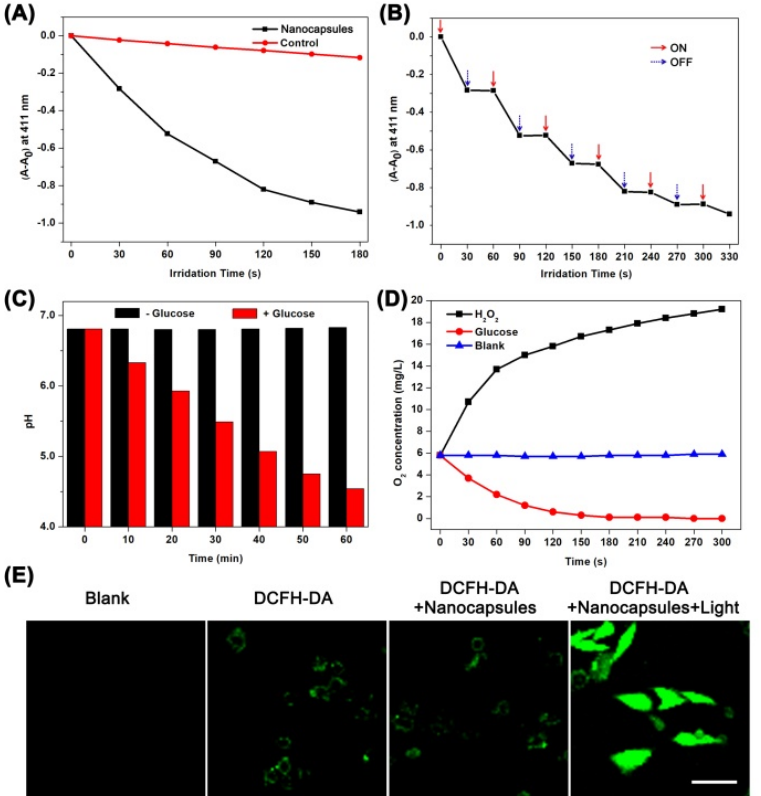
Figure 3. ( A ) The DPBF UV changes in the absence and presence of nanocapsules under infrared irradiation. ( B ) The DPBF UV changes in response of OFF-ON irradiation. ( C ) The pH value changes of GOx/CAT-NCs solution in the absence and presence of glucose. ( D ) The O 2 concentration changes of GOx/CAT-NCs solution in the presence of H 2 O 2 or glucose. ( E ) The CLSM images of 3T3 cells with various treatments. The scale bar is 20 μ m.